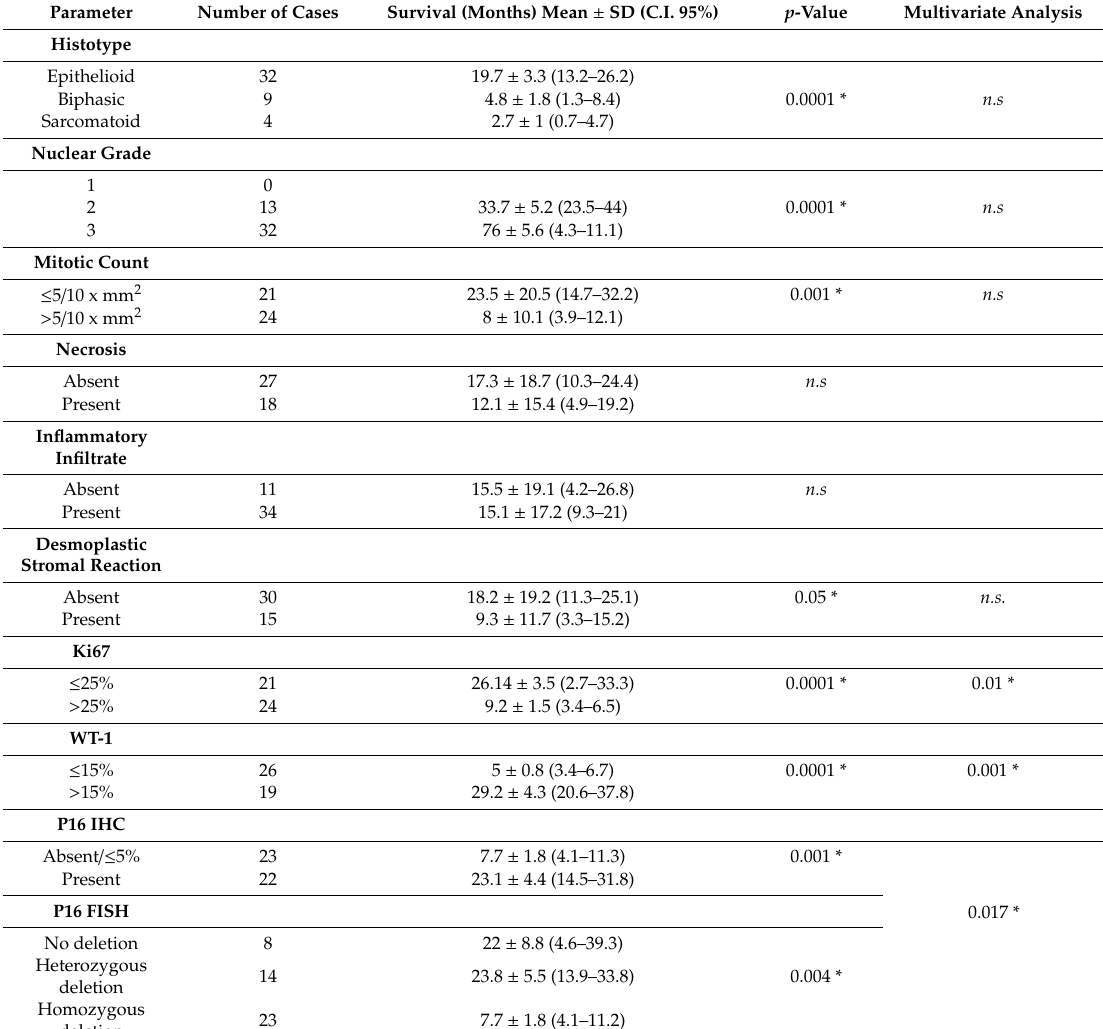
Table 1. Results of statistical analyses of histological and molecular